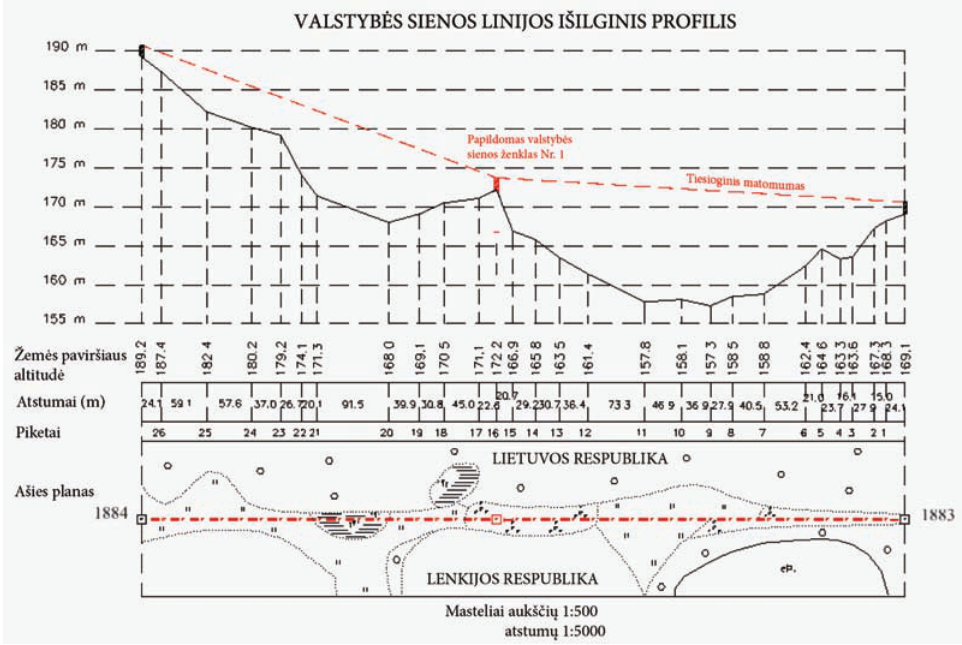
Fig. 6. State border line longitudinal